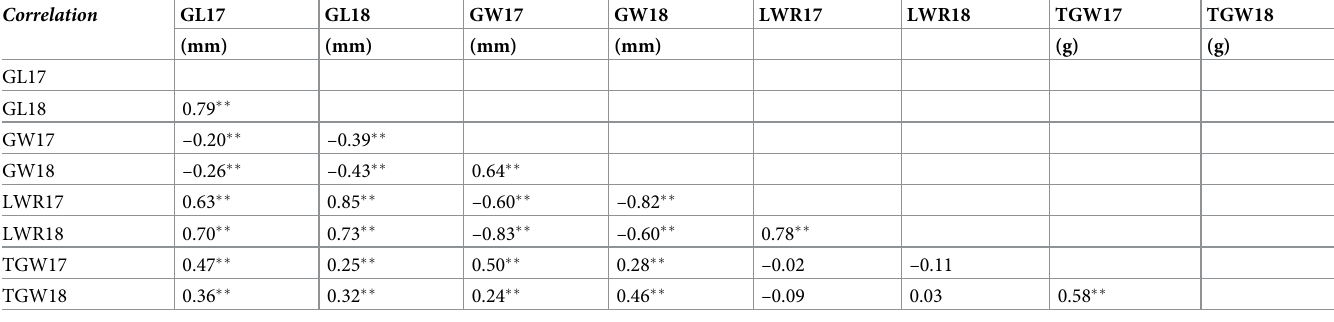
Table 2. Correlation coefficients among grain shape traits of the F 2 and its derived F 2:3 populations in 2017 and 2018, respectively.